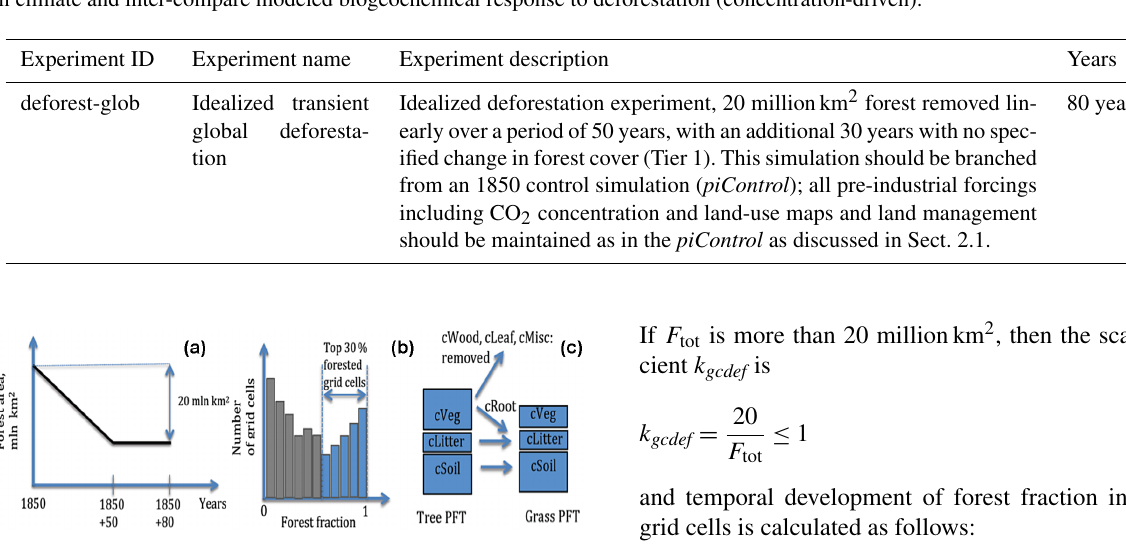
Figure 2. A schematic of the experimental setup in the deforest-glob experiment. (a) Scenario of forced changes in the global forest